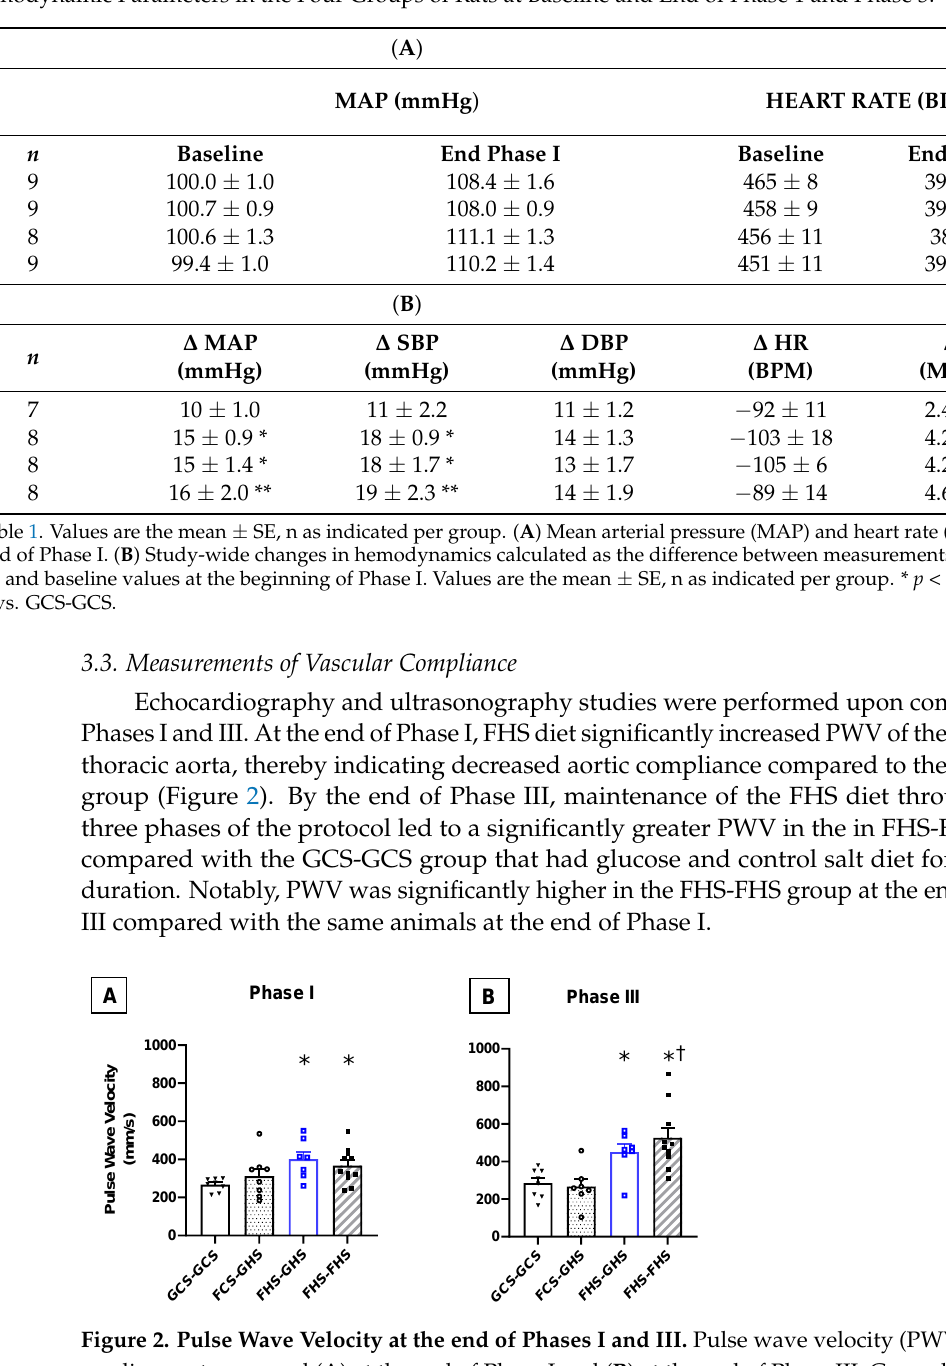
Table 3. Hemodynamic Parameters in the Four Groups of Rats at Baseline and End of Phase 1 and Phase 3. Dietary